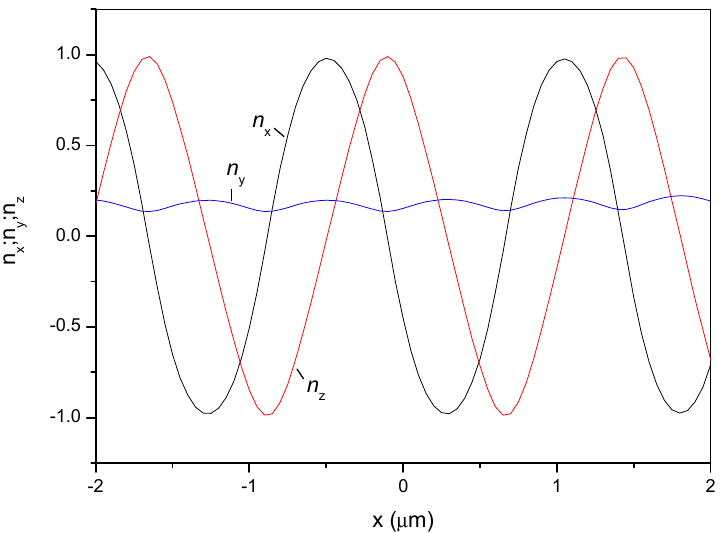
Figure 3. Director distribution in the center of a 2- µ m-thick layer at a voltage of 20 V after switching on an electric voltage with an amplitude of 20 V.